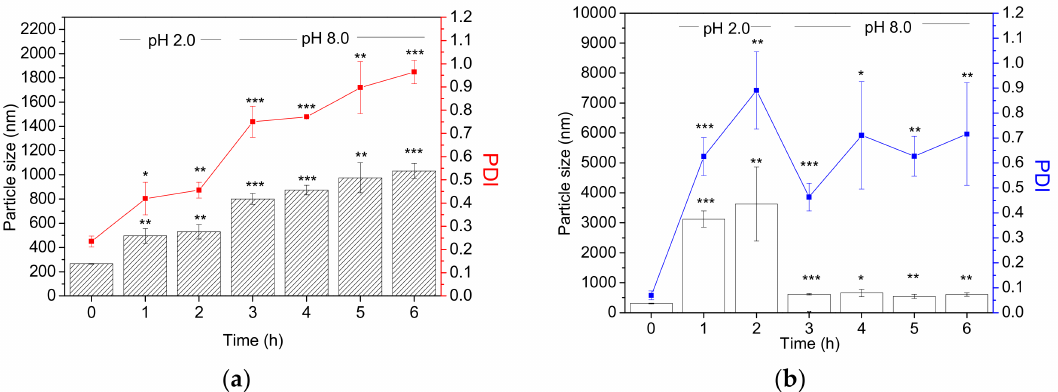
Figure 2. Particle size and distribution of the P4G6 ( a ) and P6G4 ( b ) PECs. The PECs were incubated at 37 ◦ C and pH 2.0 for 2 h, and the pH was subsequently adjusted to 8.0 for 4 h to mimic drug transits in the GI tract. At each hour, particle size and PDI were determined by DLS. The results have been statistically compared and analyzed using Student’s t -test (Microsoft Excel 2000). Differences were recognized as statistically significant when the p values were less than 0.05, and significant differences are shown in star marks (* p < 0.05; ** p < 0.01, and *** p <